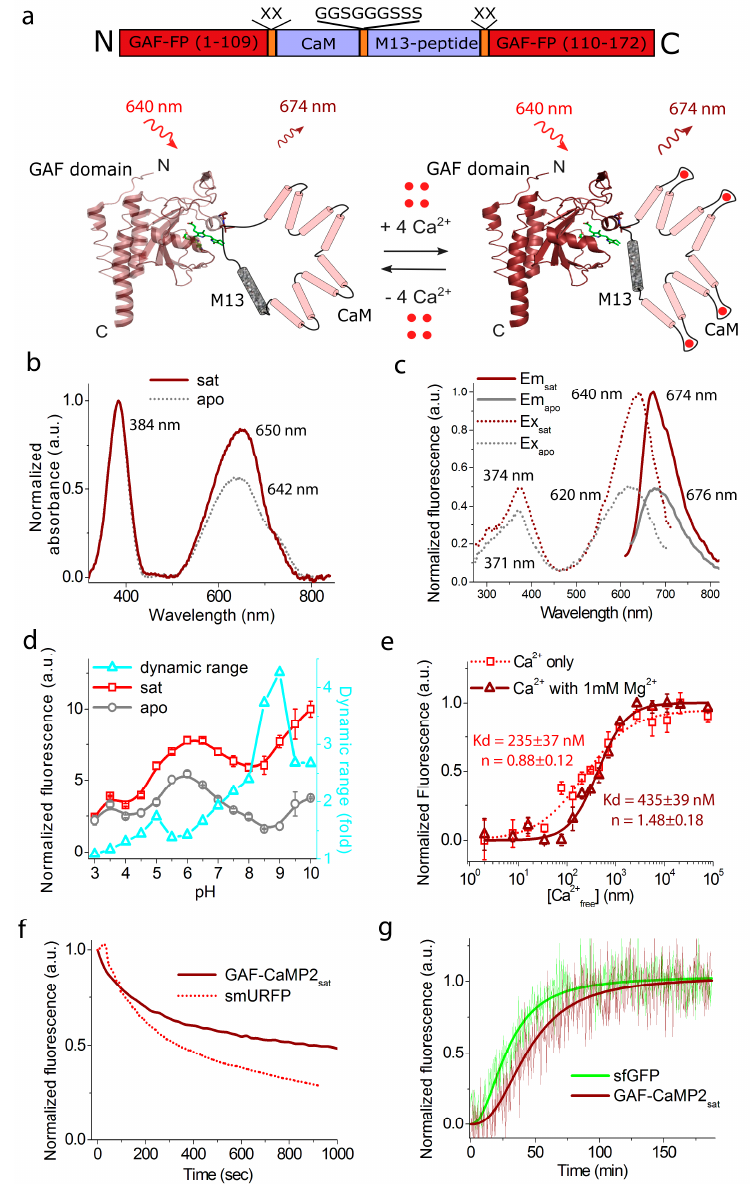
Figure 3. In vitro properties of the purified GAF-CaMP2 indicator. ( a ) A scheme of the original library for optimization of linkers in the GAF-CaMP2 indicator and suggested mechanism of its function based on the crystal structure of GAF domain (PDB 3C2W). The BV chromophore is highlighted in green. ( b ) Absorbance spectra for GAF-CaMP2 in Ca 2 + -bound and Ca 2 + -free state at pH 7.2. ( c ) Excitation and emission spectra for GAF-CaMP2 in Ca 2 + -bound and Ca 2 + -free states, pH 7.2. ( d ) Fluorescence intensity for GAF-CaMP2 in Ca 2 + -bound and Ca 2 + -free states as a function of pH. Three replicates were averaged for analysis. Error bars represent the standard deviation. ( e ) Ca 2 + titration curves for GAF-CaMP2 in the absence and in the presence of 1 mM MgCl 2 , pH 7.2. Three replicates were averaged for analysis. Error bars represent the standard deviation. ( f ) Photobleaching curves for GAF-CaMP2 in Ca 2 + -bound state and smURFP. The power of light before the objective lens was 2.23 mW / cm 2 . Four replicates were averaged for analysis. ( g ) Maturation of purified GAF-CaMP2-sfGFP sat fusion protein. The experimental data were fitted by the Hill equation. Protein maturation occurred in Ca 2 + -saturated bu ff er 30 mM HEPES, pH 7.20, 100 mM KCl, 1 µ M BV, 5 mM Ca-EDTA at 37 ◦ C. The green (ex. 460 / 10 nm, em. 520 / 10 nm) and far-red (ex. 640 / 10 nm, em. 675 / 10 nm) fluorescence were simultaneously registered for sfGFP and GAF-CaMP2 sat in their fusion,